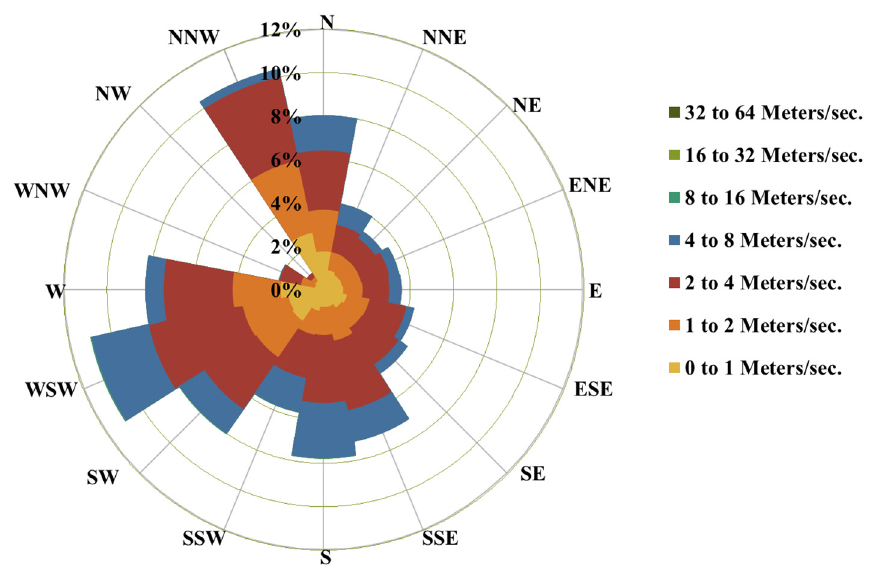
Figure 2. Chippewa Falls wind rose, October 2012–December